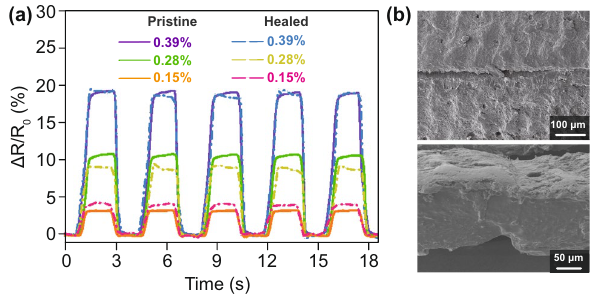
Fig. 4 a Dynamic response curves of pristine and self-healed S-50 sensors under different applied strains. b Vertical (top) and cross-sec- tional (bottom) SEM images of S-50